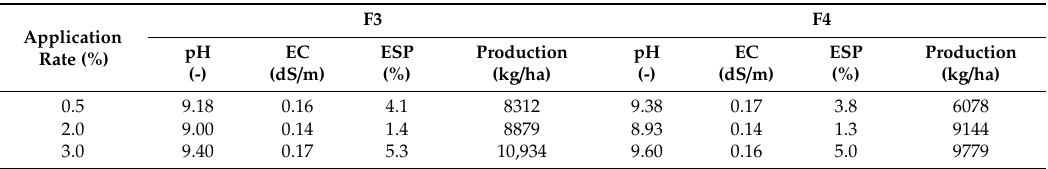
Table 6. Comparison of maize production and other parameters between experimental plots of similar soil chemical properties in F3 and F4 in